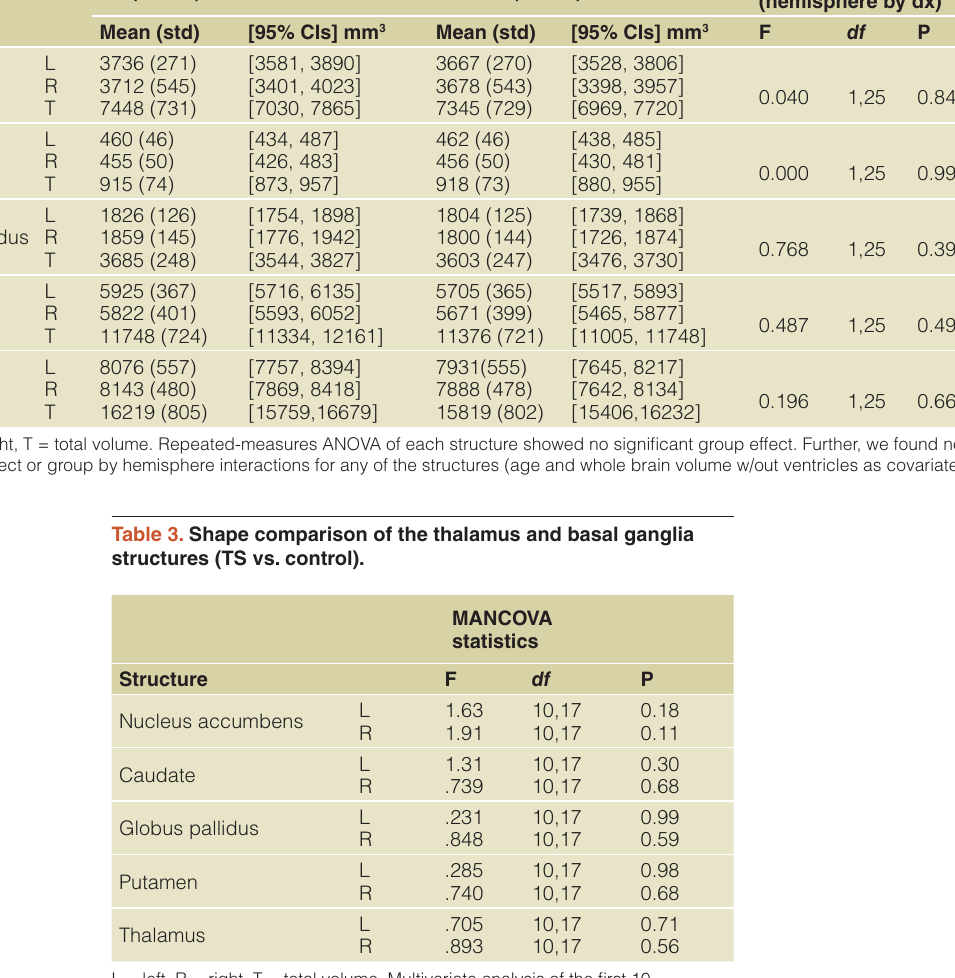
L = left, R = right, T = total volume. Multivariate analysis of the first 10 eigenvectors of each structure showed no significant group effect (age as